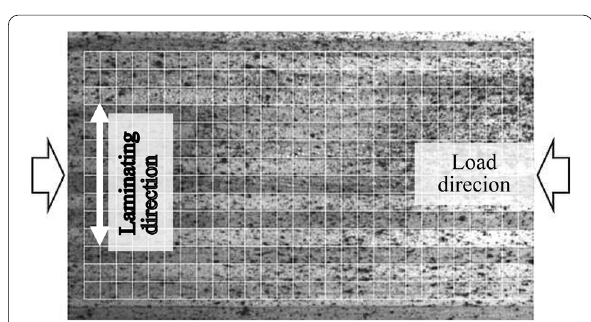
Fig. 5 Subsets for the digital image correlation analysis (white mesh on image of specimen)